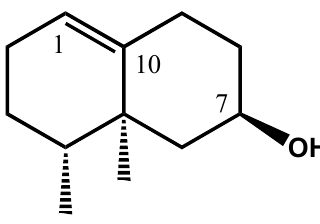
Figure 3. 11,12,13-Tri-nor-eremophil-1(10)-en-7-ol ( 16 ).